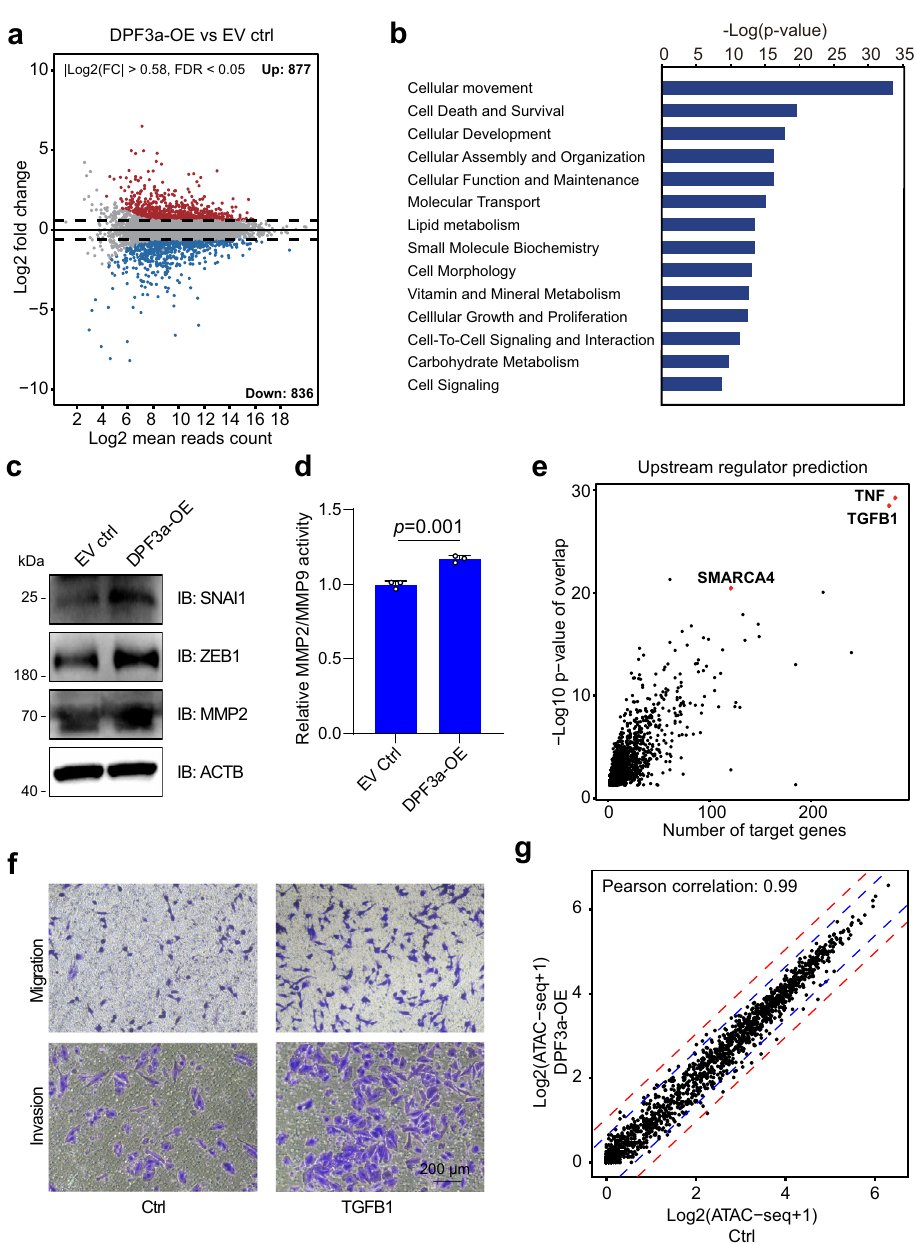
Fig.3|Comparisonoftranscriptomeandchromatinaccessibilitybetween786- Ocellswith and those without DPF3 expression.a The MA plot comparing gene expression pro fi le of 786-O cells with and those without DPF3a expression. The x-axis and y-axis represent Log2 (mean read counts) and Log2 (fold change), respectively. Red dots indicate upregulated genes, whereas blue dots